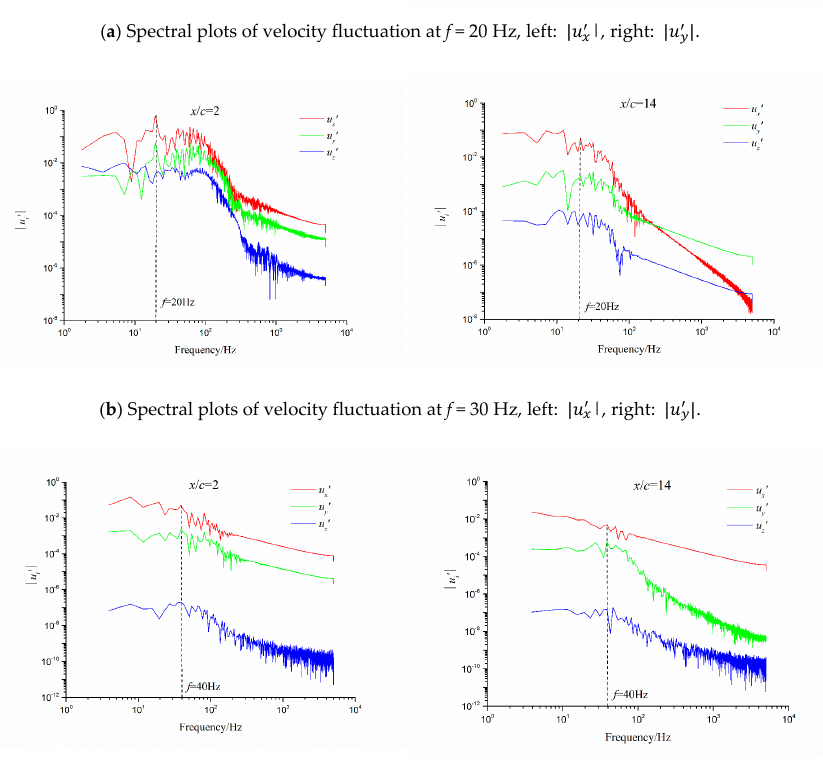
( c ) Spectral plots of velocity fluctuation at f = 40 Hz, left: |(cid:1873) (cid:3051)(cid:4593) |, right: |(cid:1873) (cid:3052)(cid:4593) | . Figure 9. Spectral plots of velocity fluctuation at y/Ls = 0.25 with different RSI frequency: ( a ) f = 20 Hz ( b ) f = 30 Hz ( c ) f = 40 Hz. ( b ) f = 30 Hz ( c ) f = 40